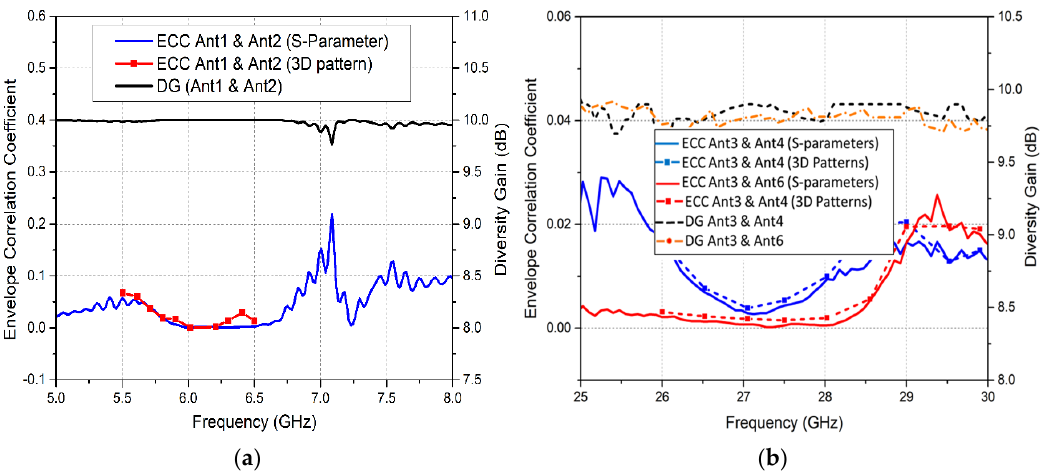
Figure 15. ECC and Diversity Gain for ( a ) LTE MIMO Antennas; ( b ) 5G MIMO